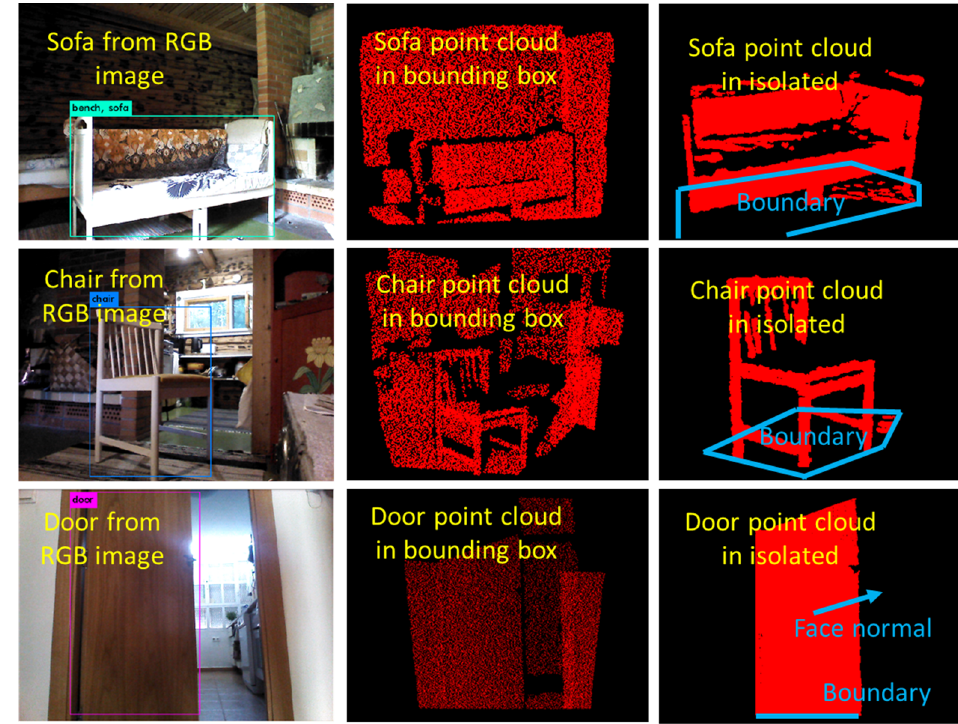
Figure 4. Point cloud processing pipeline for isolating and determining the location of a general object.